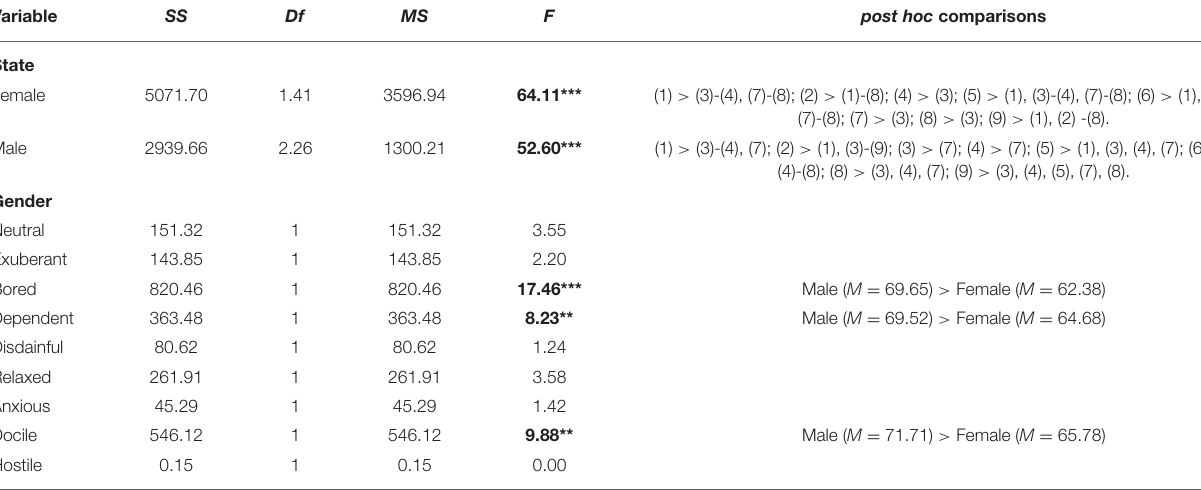
TABLE 7 | Simple main effect test using mixed design of gender and emotional states on intensity (dB).